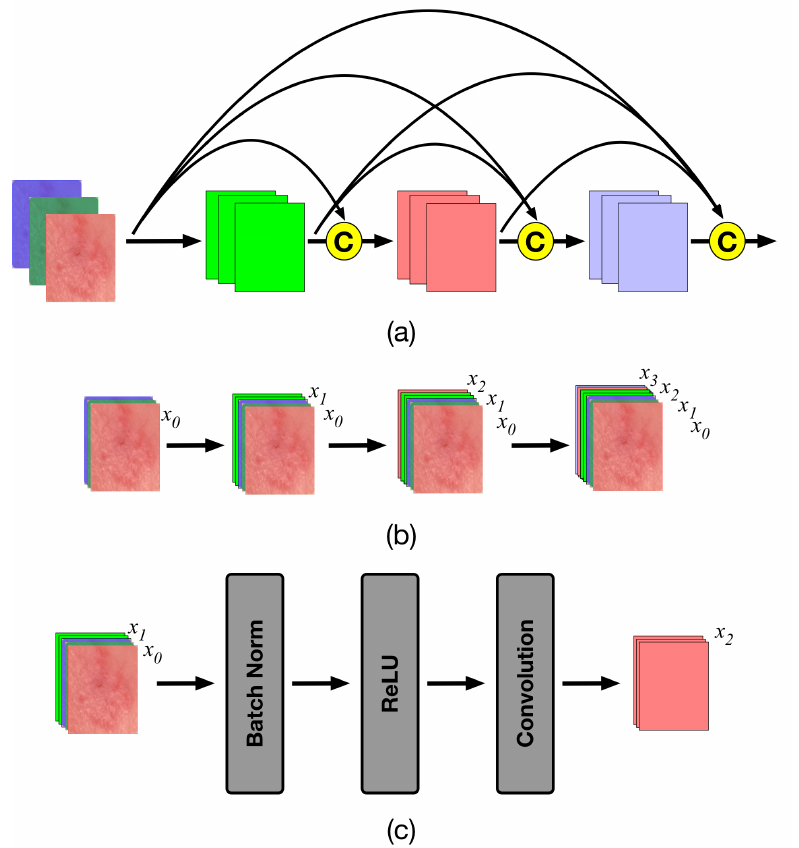
Figure 3. DenseNet architecture. ( a ) Block diagram of the concatenation operation, indicated by a C within a yellow circle. ( b ) Block diagram of the forward propagation. ( c ) Block diagram of the layer